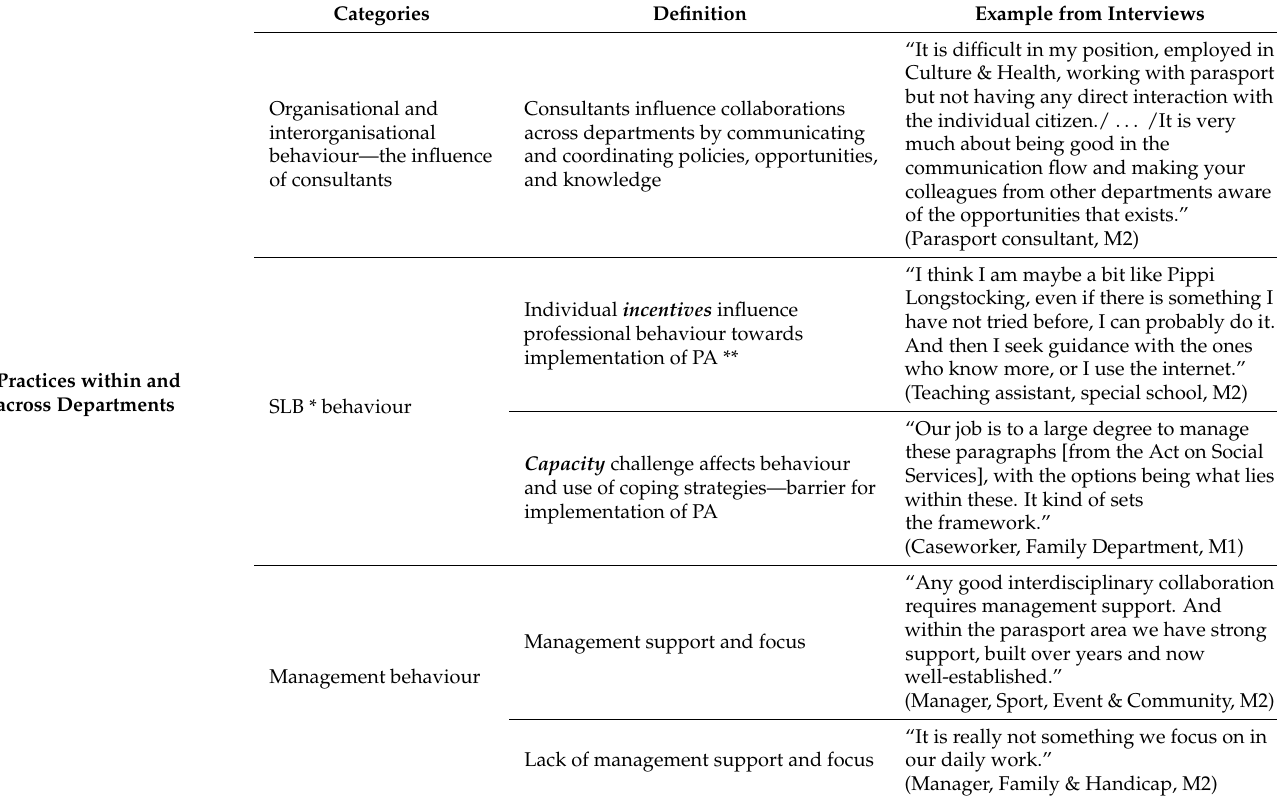
Table A2. Example of the coding